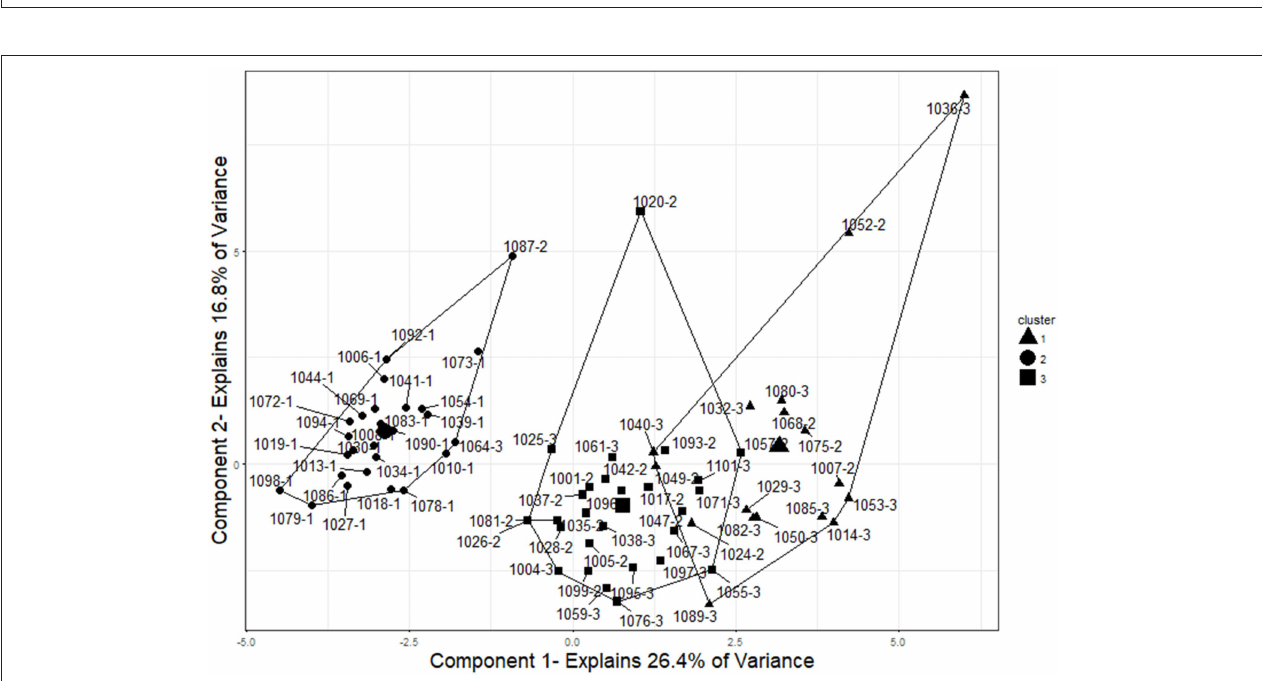
FIGURE 7 | Three-cluster solution for examinees. The three clusters represent good separation between control (IDs that end in − 1), ItemOnly (IDs that end in − 2), and Item + Answer (IDs that end in − 3) participants. The cluster centers and cluster membership are indicated by shape (circles represent the cluster of size 26, squares represent the cluster of size 27, and triangles represent the cluster of size 17). Two examinees were grouped incorrectly by this analysis (1064-3 and 1087-2). To visualize the cluster results, components were obtained using principal component analysis, and the clusters are plotted on those components. This plot was created using the “fviz_cluster” function in the “factoextra” package of R (Kassambara and Mundt, 2017).